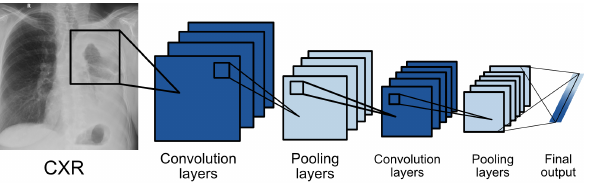
Figure 1. The CNN architecture consists of convolutional and pooling layers and fully connected output layer at the end to provide the final prediction.